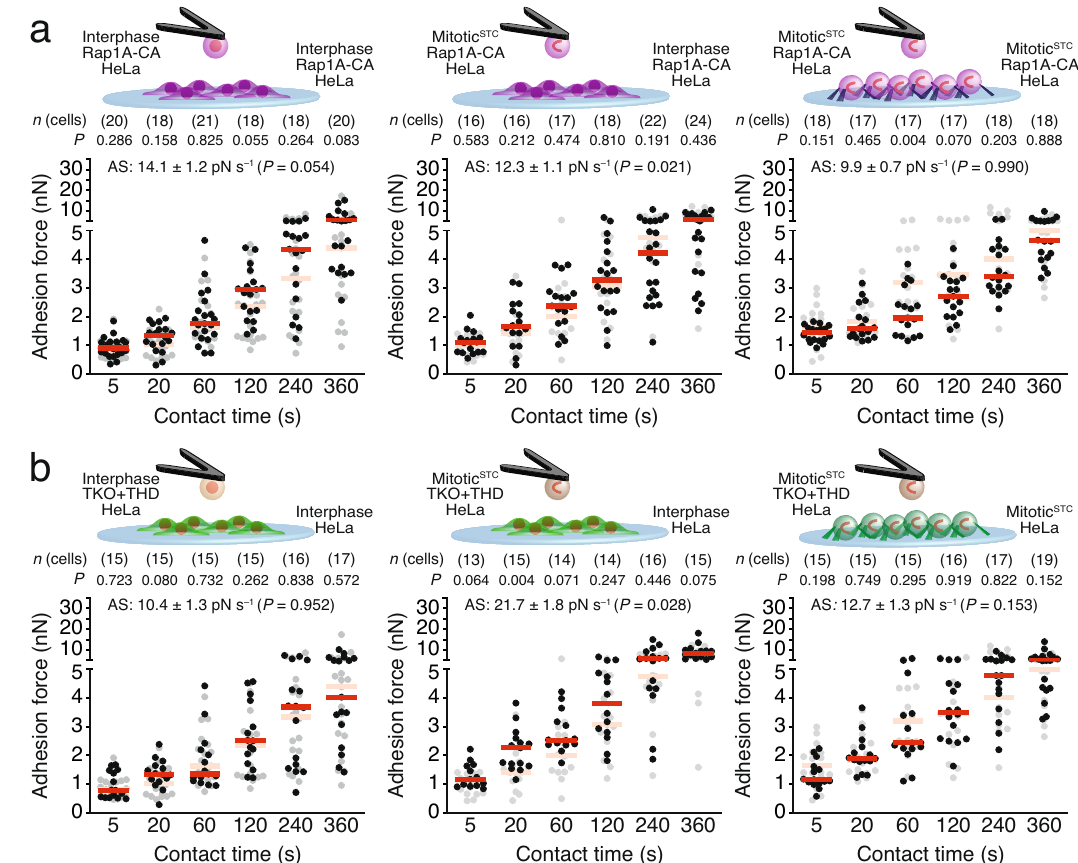
Fig. 7 | Talin1-head domain expression in mitotic talin-de fi cient HeLa cells recovers cell – cell adhesion defects. a Cell – cell adhesion forces established between two interphase (left), an interphase and a mitotic STC (middle), or two mitotic STC (right) Rap1A-CA. b Cell – cell adhesion forces between interphase TKO+THD and interphase wildtype (left), mitotic STC TKO+THD and interphase wildtype (middle) or mitotic STC TKO+THD and mitotic STC wildtype (right) HeLa cells. Dots represent adhesion forces between single cantilever-bound and substrate-spread cells, red bars their medians and n (cells) the number of inde- pendent cells in at least three independent experiments. As reference for cell – cell